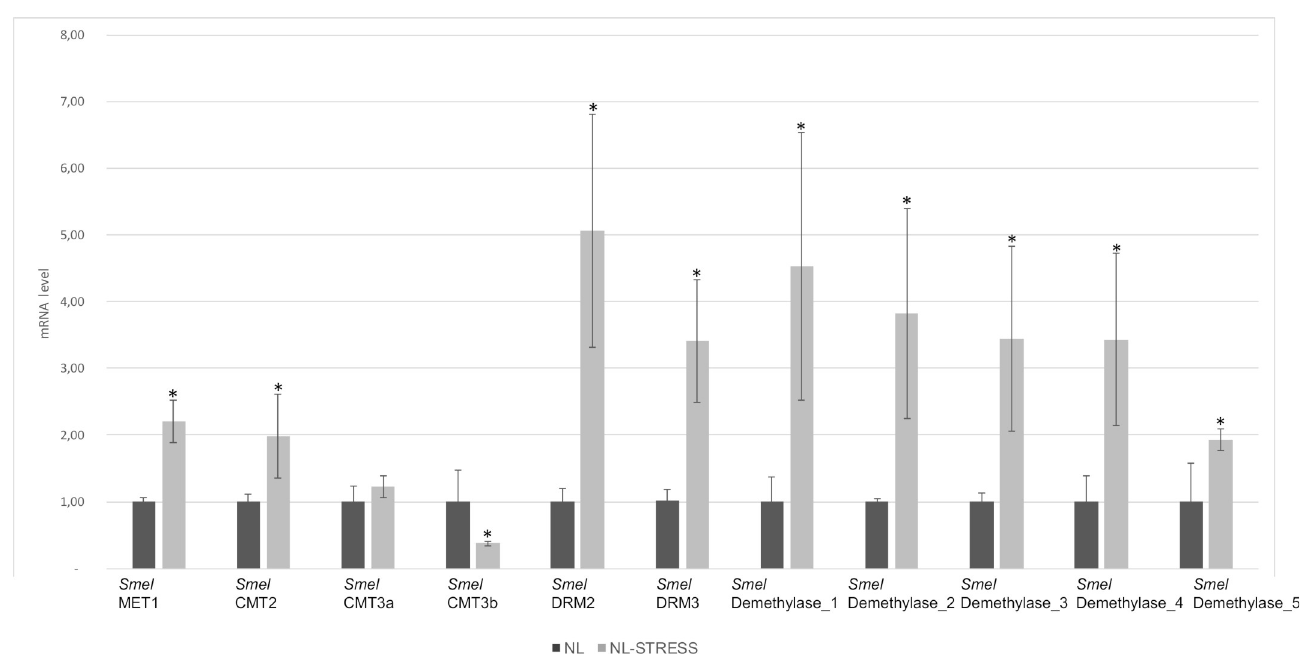
Fig 7. The patterns of expression of C5-MTase and DNA demethylase in leaf tissues of the F1 hybrid ‘Nite Lady’ in response to drought stress. The actin eggplant gene was used as the reference sequence. Error bars represent SD ( n = 3). Asterisk indicates a significant difference based on Tukey’s HSD (P � 0.05).